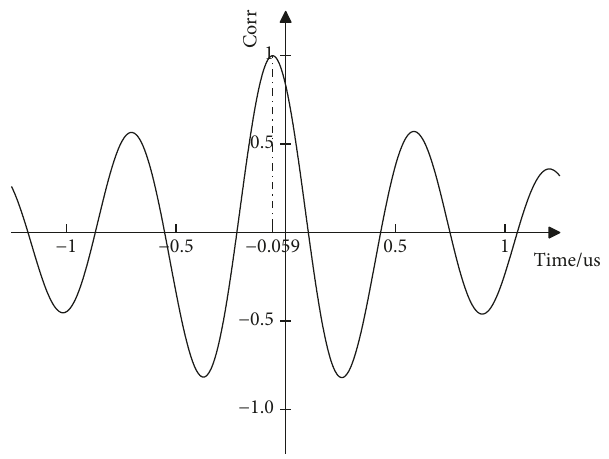
Figure 10: Cross-correlation of ultrasonic signals under two di ff erent stress states.